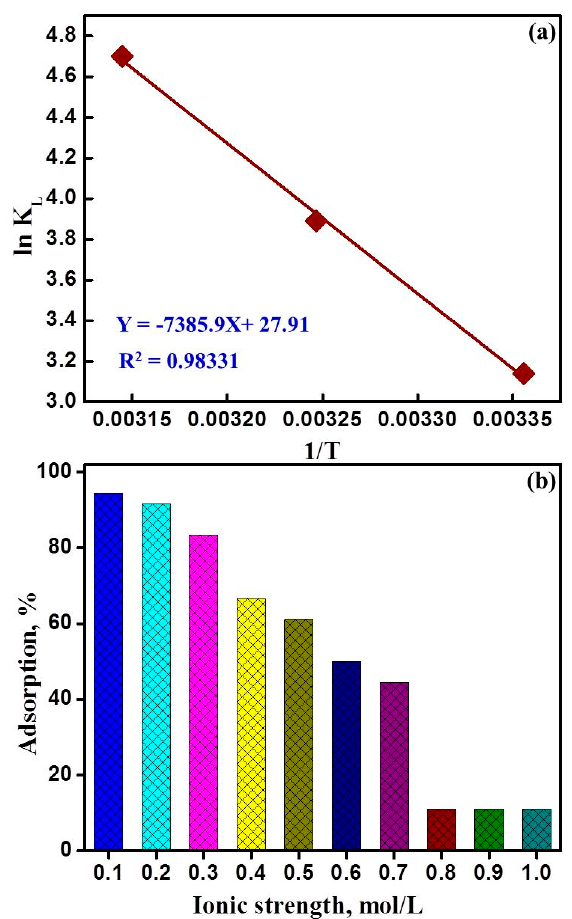
Figure 8. ( a ) Van’t Hoff plot for the adsorption of uranyl ions on mesoporous NaZrP-CEX cation-exchanger and ( b ) Effect of ionic strength on the adsorption of uranyl ions on mesoporous NaZrP-CEX cation-exchanger.